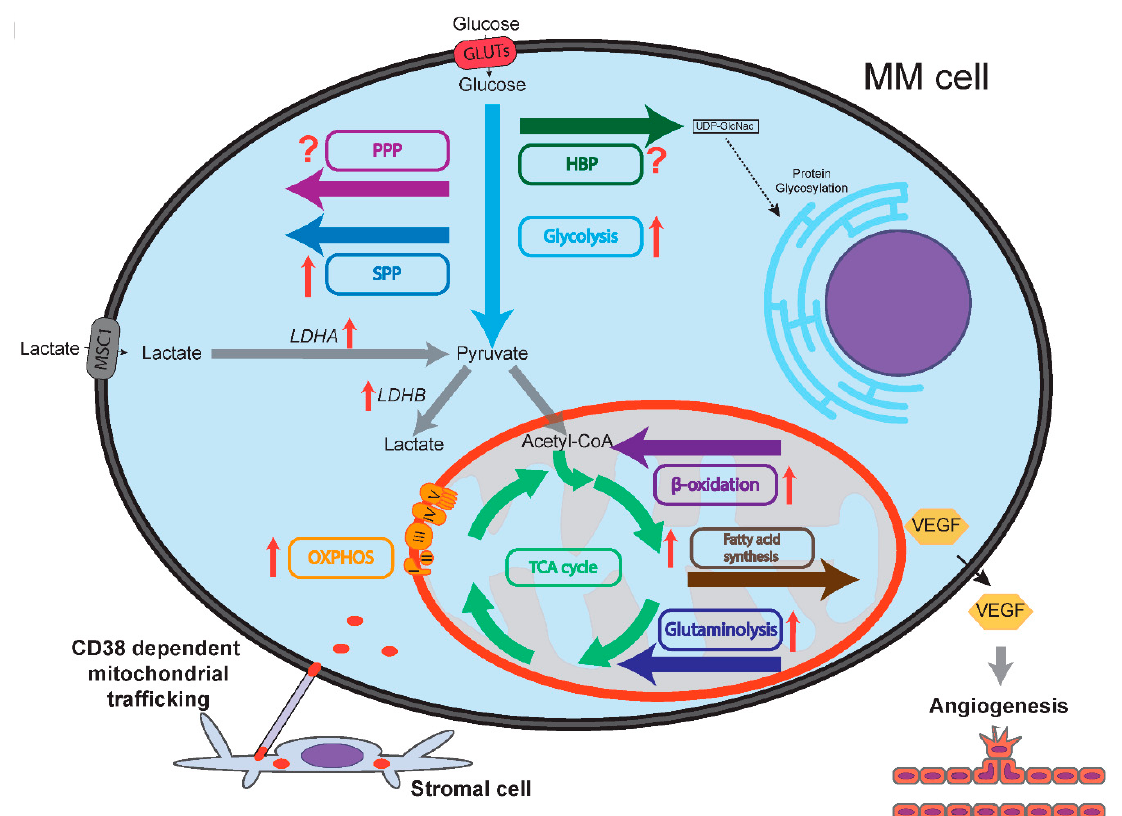
Figure 1. Schematic representation of multiple myeloma (MM) cell metabolism compared to normal plasma cells. Flow of metabolites is shown by colored arrows. Glycolysis, OXPHOS, serine synthesis pathway (SSP), glutaminolysis, fatty acid synthesis and fatty acid oxidation ( β -oxidation) are all upregulated in MM cells compared to normal plasma cells, as indicated by red arrows. Lactate dehydrogenase A ( LDHA ) and B ( LDHB ) are upregulated in MM cells. It is unclear whether the pentose phosphate pathway (PPP) and the hexosamine biosynthesis pathway (HBP) are up/downregulated in MM cells compared to normal plasma cells, as designated by question marks. MM cells express vascular endothelial growth factor (VEGF) that increases bone marrow oxygenation by inducing angiogenesis. Increased bone marrow oxygenation may stimulate oxidative phosphorylation (OXPHOS) in MM cells. CD38-dependent nanotubes transport mitochondria from stromal cells to MM cells, mitochondrial fusion further sustains OXPHOS.